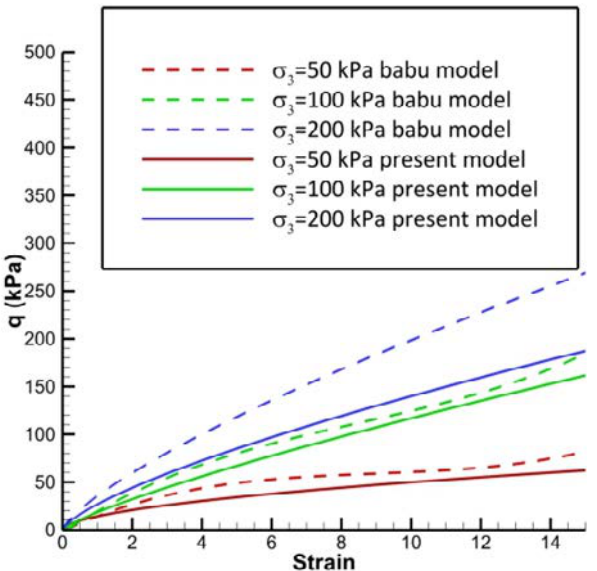
Fig. 5: Comparison of the presented model and the Babu’s model at confining stresses of 50, 100, and 200 kPa